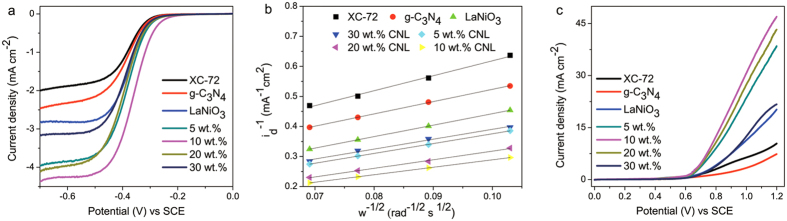
(a) ORR polarization curves, (b) Koutecky-Levich plots and (c) OER polarization curves of XC-72, g-C3N4, LaNiO3 and x wt.% CNL (x = 5, 10, 20 and 30) catalysts.